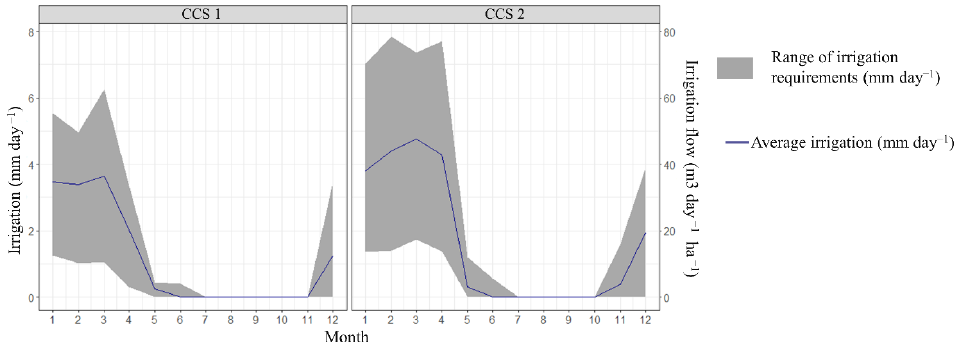
Figure 12. Water requirements for the selected APBs under CCSs. The range of irrigation require- ments in the selected APBs is presented in mm per day (left axis) and in flow values in cubic meters per day per hectare (right axis), for each month in each CCS.